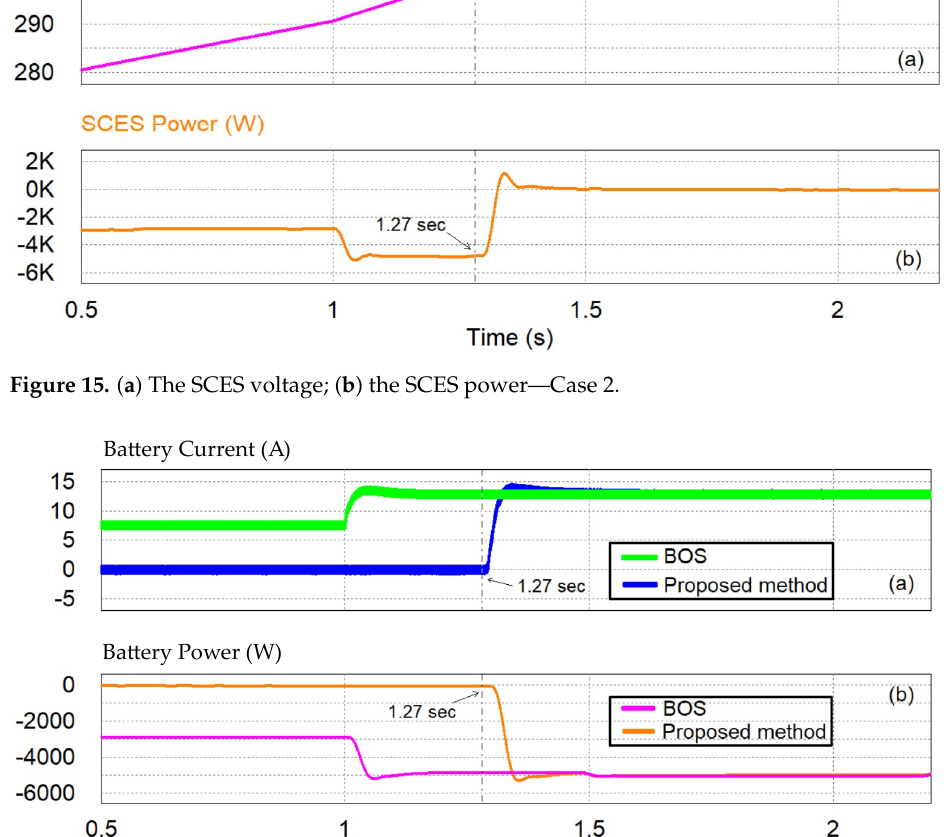
Figure 16. ( a ) The battery current; ( b ) the battery power—Case 2.